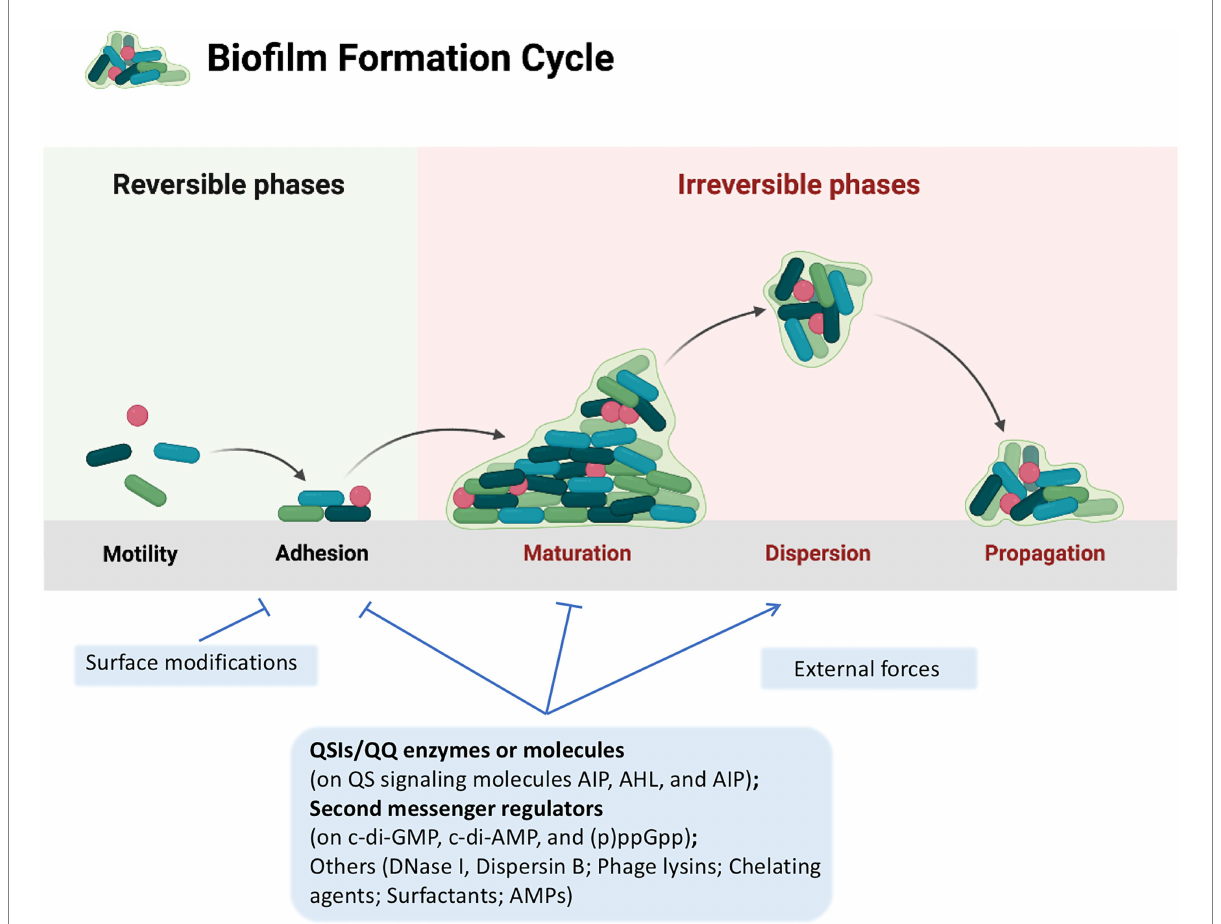
FIGURE 1 A typical biofilm cycle and the strategies to control biofilm formation. A typical biofilm formation consists of five stages: (i) reversible attachment to surface; (ii) irreversible attachment to surface; (iii) microcolony formation; (iv) maturation of biofilm; and (v) biofilm dispersal. Strategies for combating bacterial biofilms are classified into three main categories: (i) changing the properties of susceptible surfaces to prevent biofilm formation; (ii) regulating signaling pathways to inhibit biofilm formation; and (iii) applying external forces to eradicate the biofilm, which are displayed in light blue rectangles. Strategies discussed in this review are presented in bold. Lines with arrow head, positive regulation; Lines with stops, negative regulation. This figure was created with